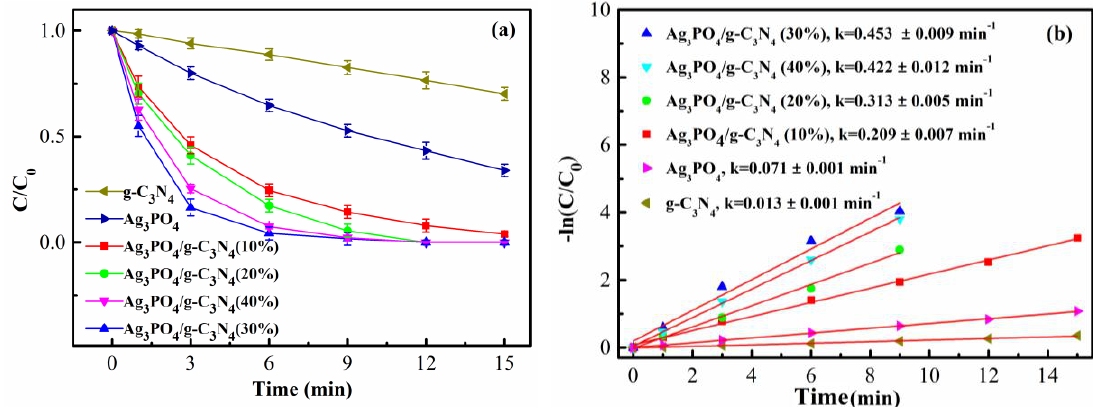
Figure 7. ( a ) DCF photodegradation with different photocatalysts, [DCF] = 1 mg L −1 , [photocatalyst] = 0.1 g L −1 ; ( b ) The kinetic constants of g-C 3 N 4 , Ag 3 PO 4 , and Ag 3 PO 4 /g-C 3 N 4 (X) for the DCF photodegradation.